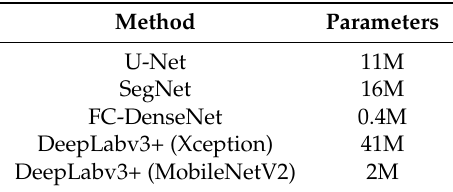
Table 2. Number of parameters of each